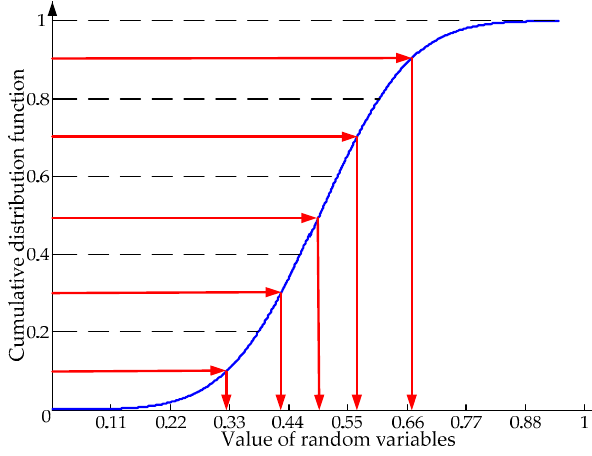
Figure 4. The structure of Latin hypercube sampling.